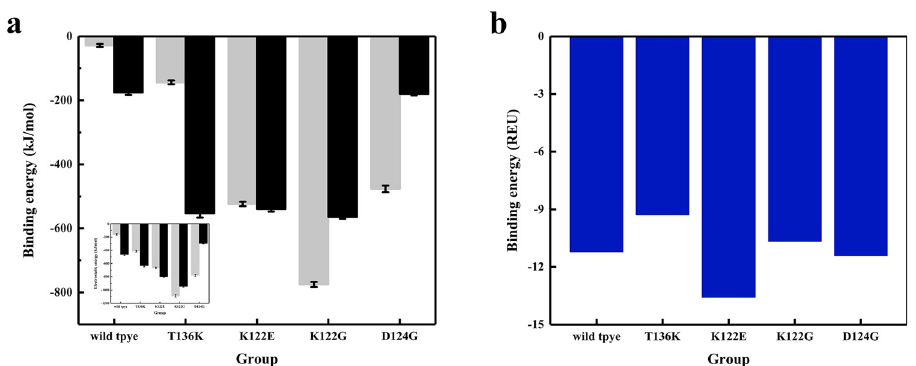
Fig 7. (a) Binding energy and electrostatic energy of wild-type and mutants, where the gray and the black bars are the results of two simulation calculations. (b) The binding energy of the complexes formed by random docking. REU is the Rosetta energy